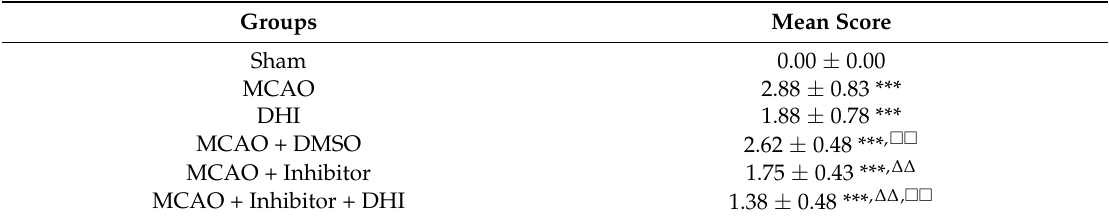
Figure 6. A validation experiment of the candidate protein Gsk-3 β and its inhibitor and the network of the 12 candidates. ( A ) Twenty-four hours after MCAO operation, Longa’s Neurological Severity Score from the model group revealed remarkable ischaemic injury, while DHI, Gsk-3 β inhibition and DHI + GSK-3 β can observably decrease the scores, indicating improved neurological function in MCAO rats (Table 4, a rank sum test was used); ( B ) the brains were stained with TTC; ( C ) the mean infarct volumes in these groups (Table 5, t -test was used); ( D , E ) validation of the hippocampus proteins from these groups by Western blotting and t -test was used to test the quantitative data. The results indicated that the rats treated with the Gsk-3 β inhibitor in combination with DHI showed a lower degree of ischaemic injury ( F ) Network of the 12 potential candidate proteins by STRING analysis. Table 4. The neurological deficit scores of groups for the Gsk-3 β validation experiment.